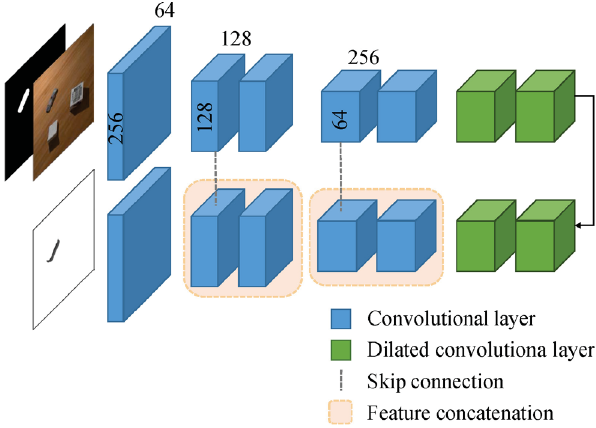
Fig. 3 Conditional shadow map